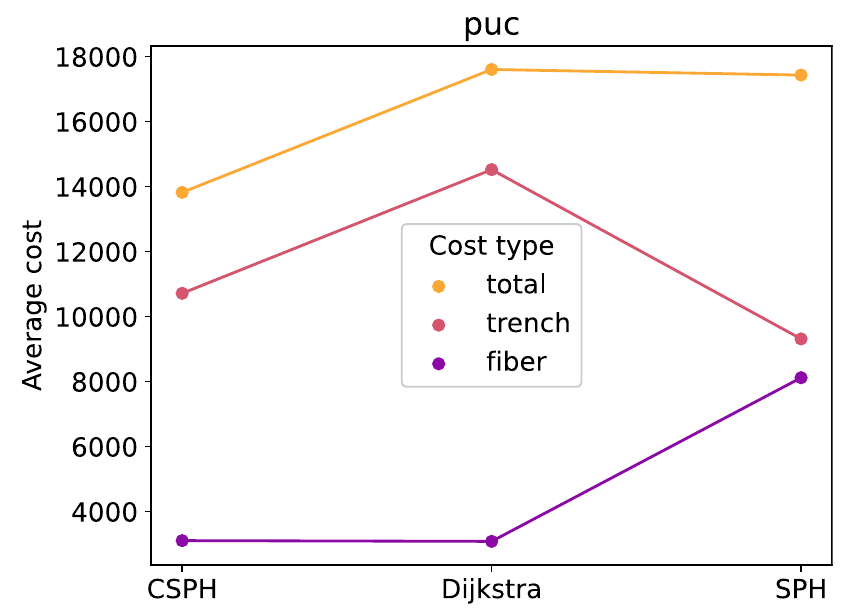
Fig 5. Lin time evolution by method. Evolution of the time cost of Dijkstra, SPH and CSPH. Includes a quadratic and linear function to compare trends.